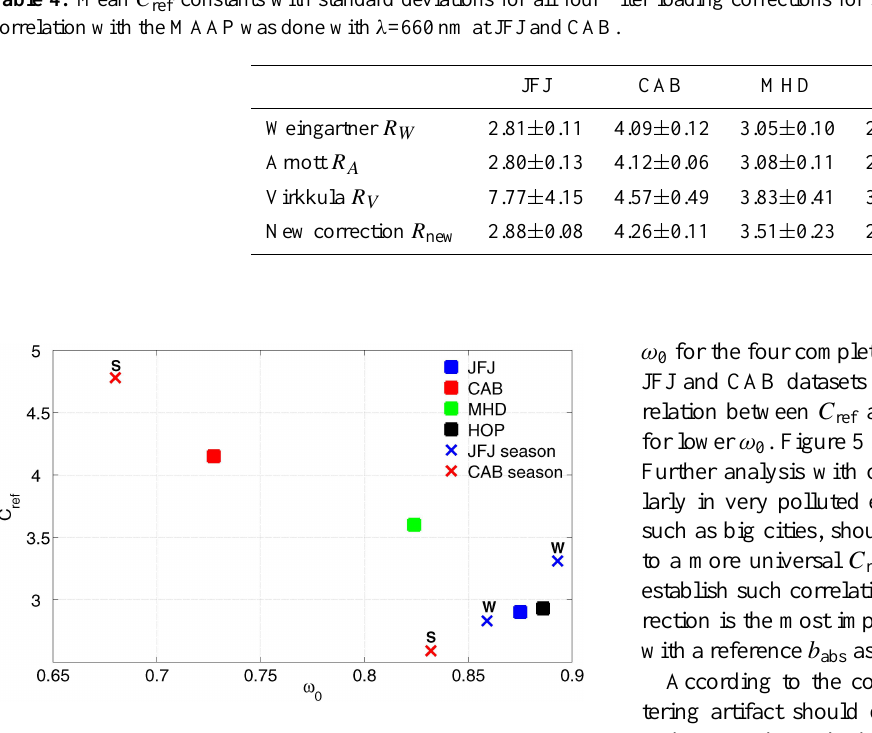
Fig. 5. C ref as a function of the single scattering albedo ω 0 for the JFJ, CAB, MHD and HOP datasets. For the JFJ and CAB datasets, C ref and ω 0 are also separated between summer (S) and winter